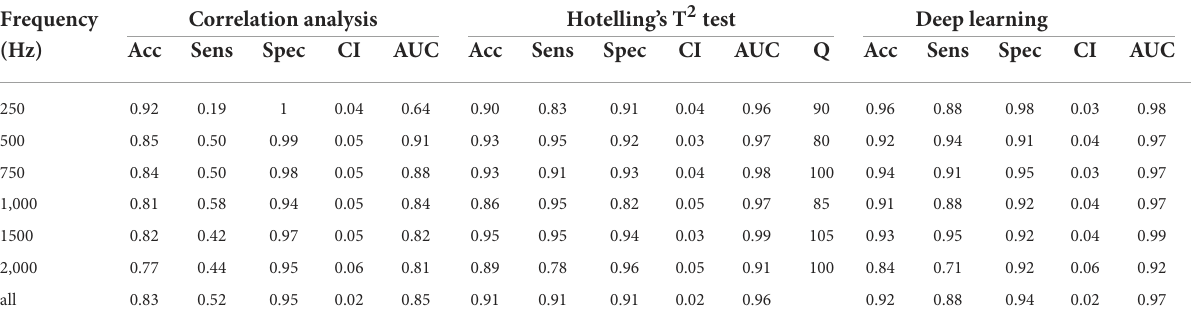
TABLE 5 Performance of objectification methods.